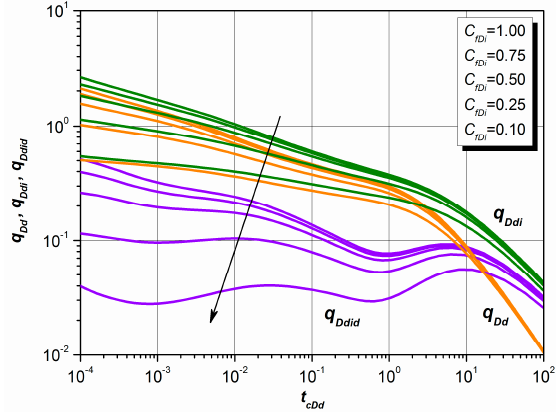
Figure 8. The effect of total fracture conductivity on combined type curves of an MFHW.